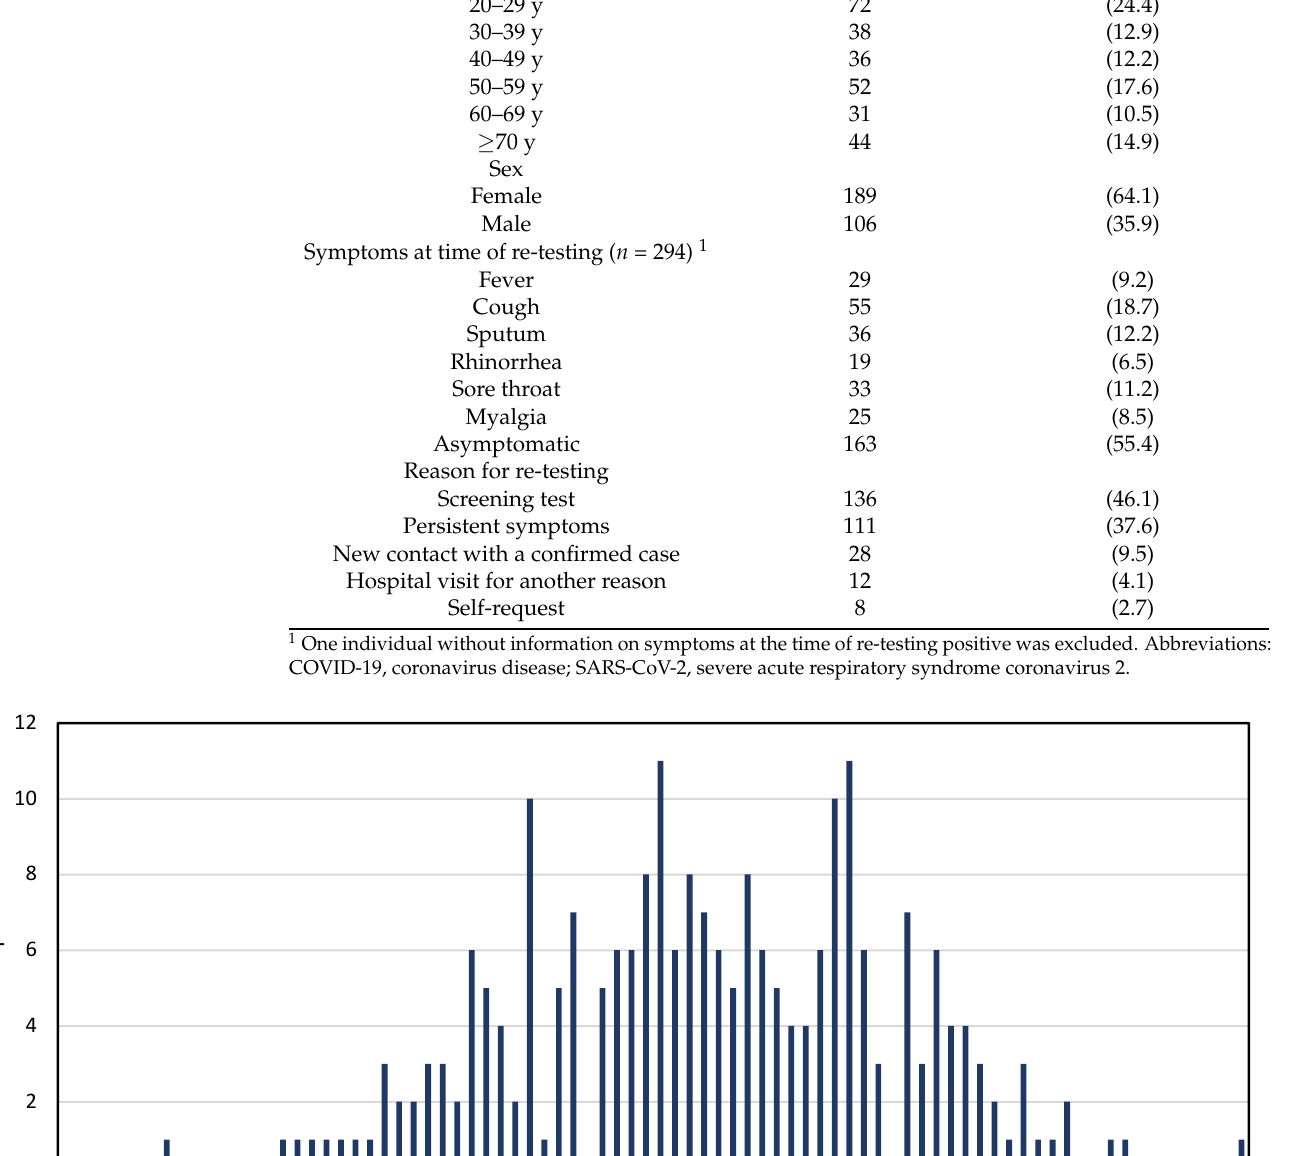
Table 1. Clinical characteristics of individuals with confirmed re SARS-CoV-2 positivity on PCR testing after recovery from COVID-19, Republic of Korea, 2020 ( n = 295).